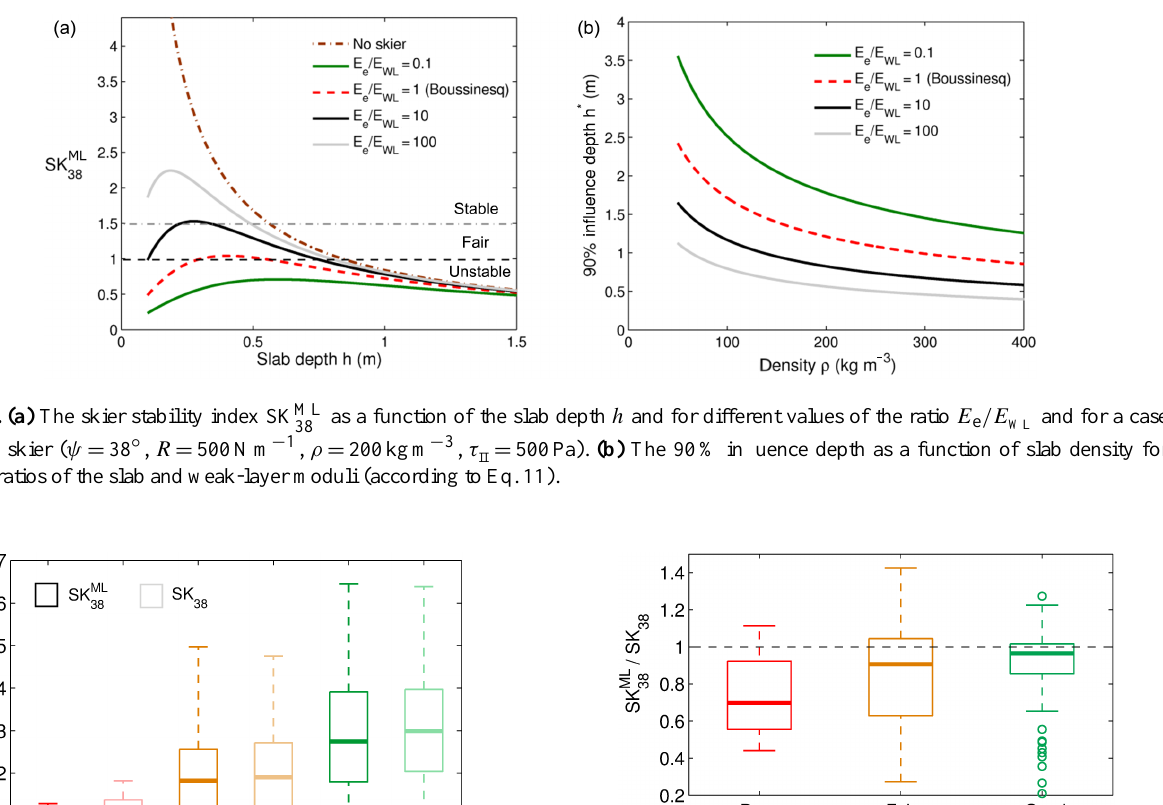
Figure 8. Distributions of the ratio between SK ML and SK 38 per 38 observed stability class (poor: manual profiles with RB scores 1 and 2, fair: manual profiles with RB scores 3 and 4, good: manual pro- files with RB scores 5, 6 and 7). Four outliers ( > 1.5) not shown. lated with the average values of the data set: (cid:104) h tot (cid:105) = 0.76 m, (cid:104) h (cid:105) = 0.0147 m, (cid:104) E (cid:105) = 1.5 WL WL